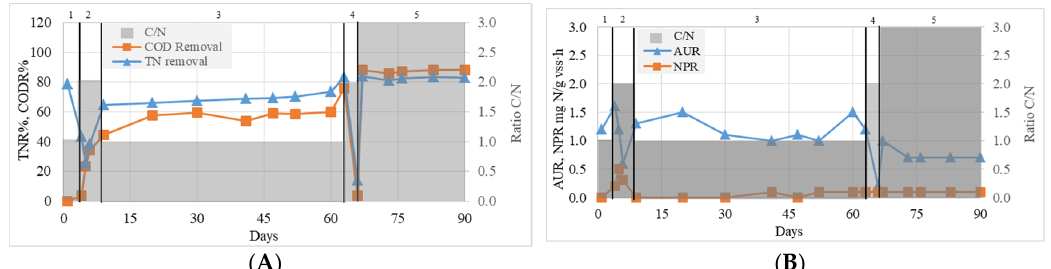
Figure 2. C/N ratio, COD (chemical oxygen demand) and TN (total nitrogen) removal efficiencies ( A ) AUR (ammonium utilization ratio) and NPR (nitrate production rate) ( B ) values in each phase of the 1st series.